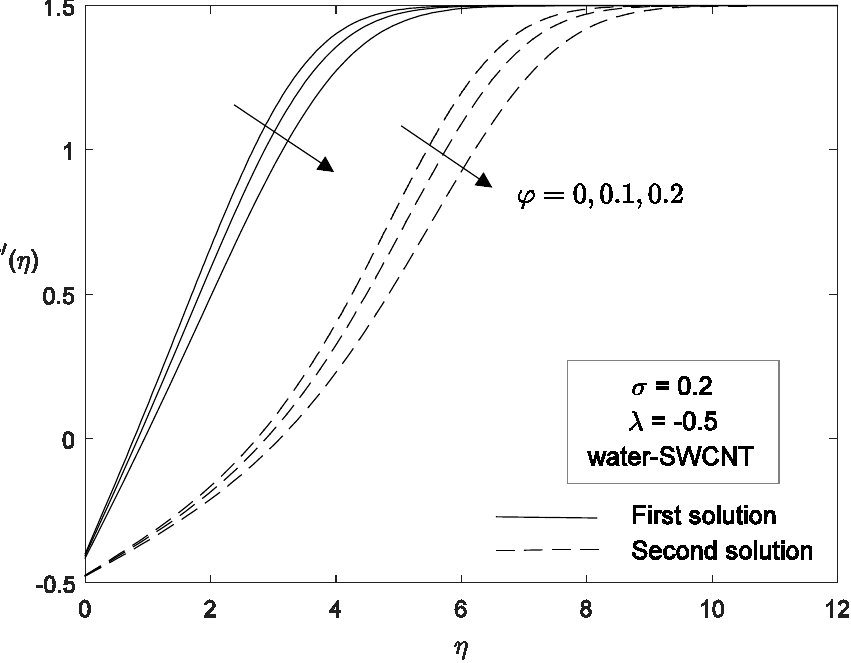
Figure 18. Effect of various ϕ on velocity profile.